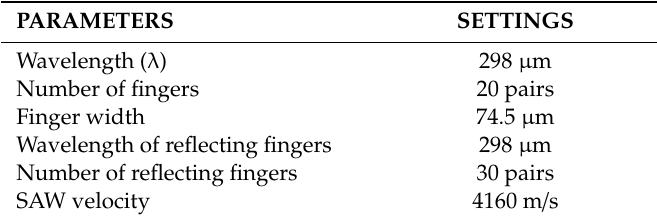
Table 1. Device IDT parameters used in both device fabrication and modeling.